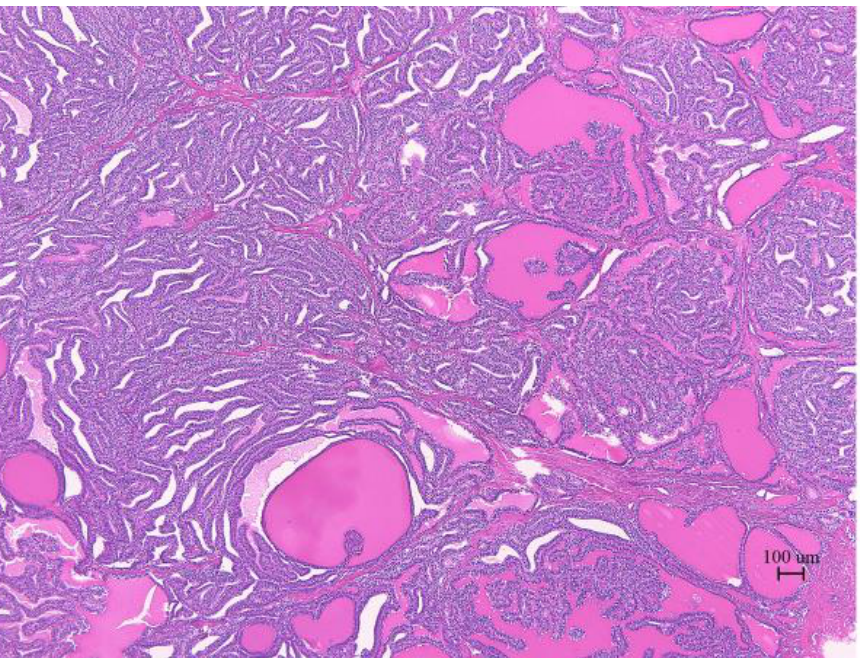
Figure 3. Micrograph (H&E staining) of the malignant struma ovarii. The thyroid follicular structure was the main component.